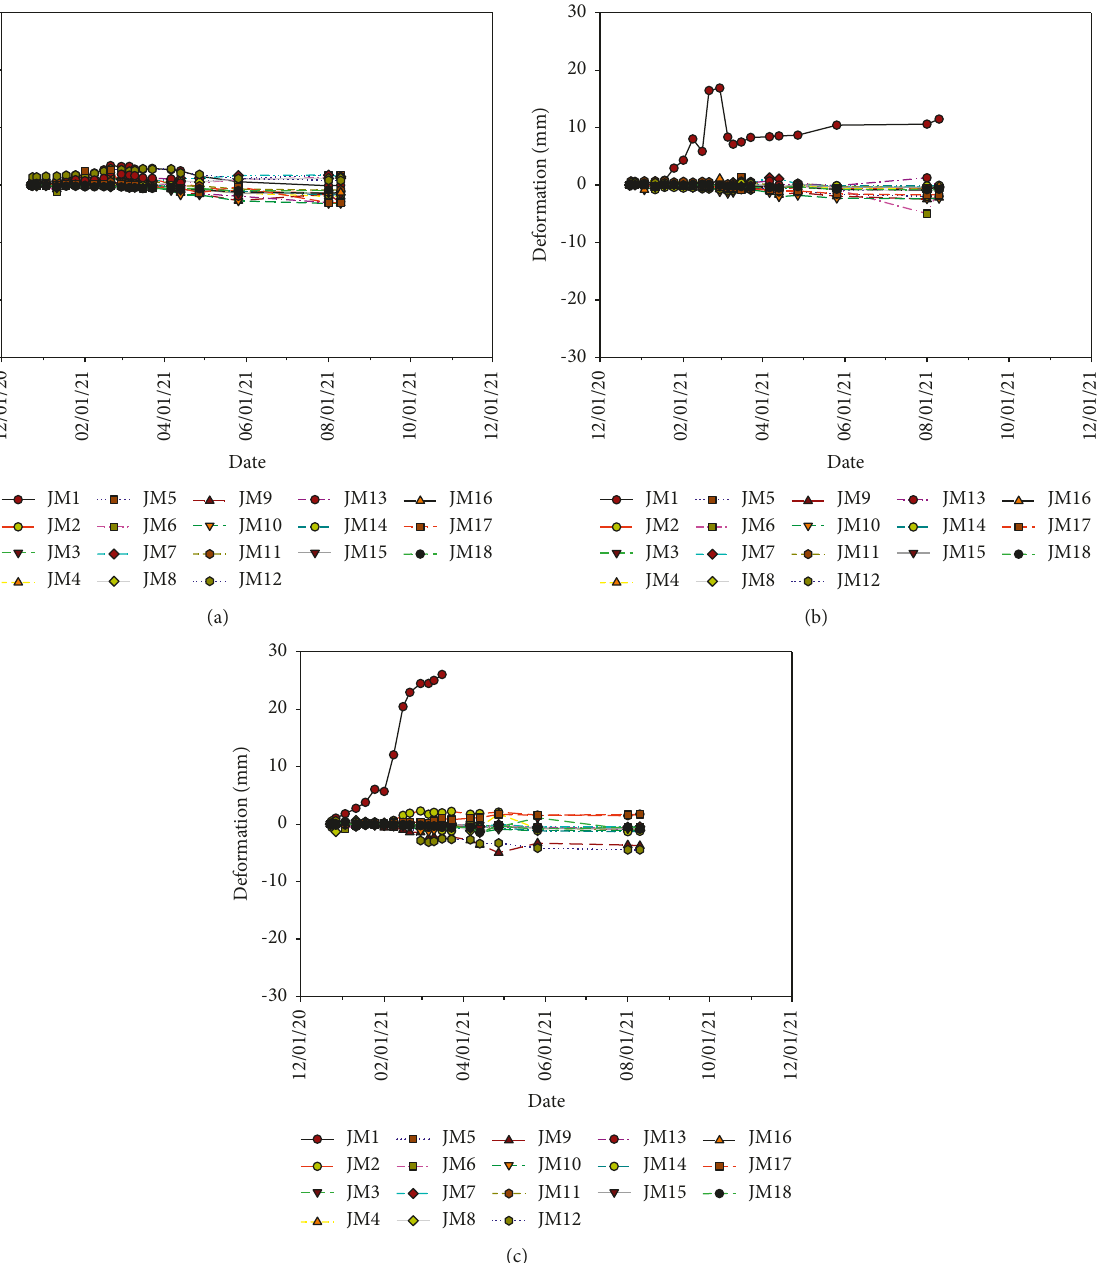
Figure 23: (a) Displacement measured in X direction, (b) displacement measured in Y direction, and (c) displacement measured in Z